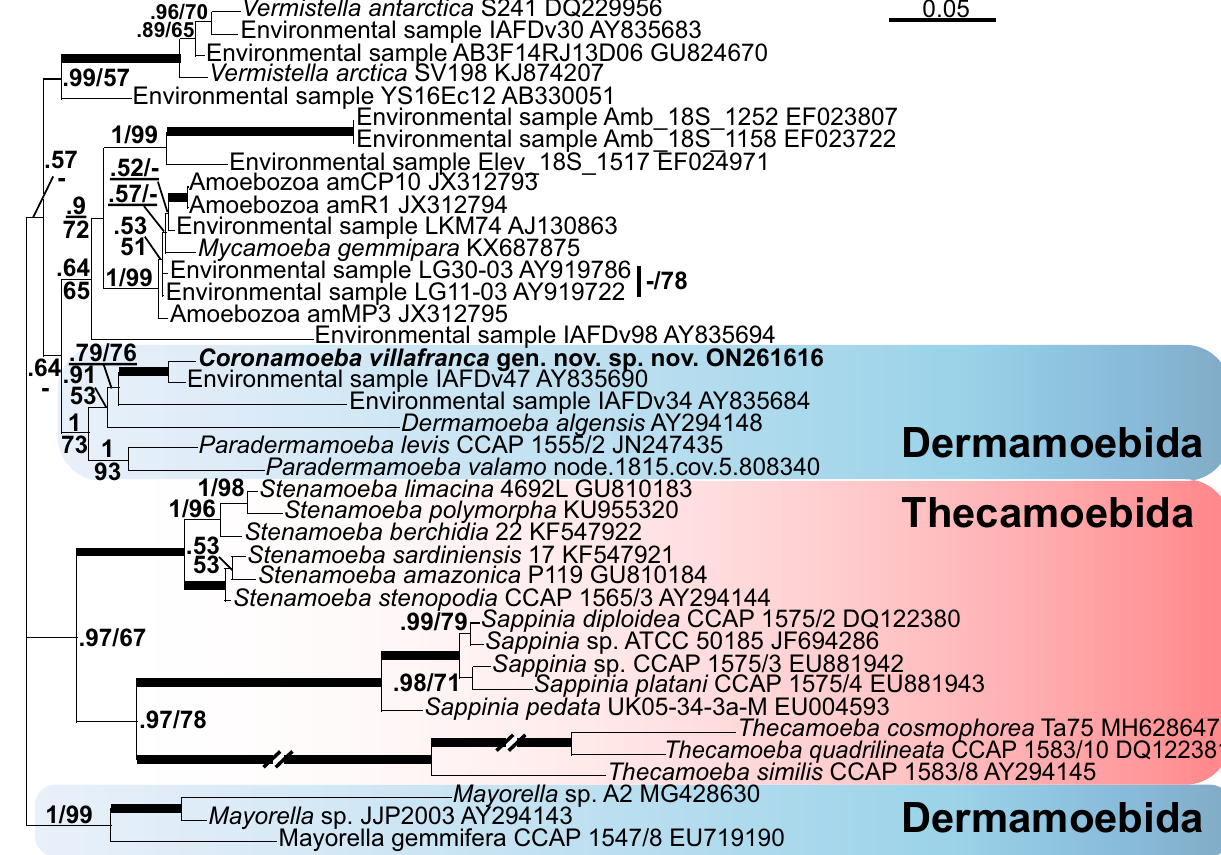
Figure 5. Part of the maximum likelihood phylogenetic tree based on the analysis of concatenated alignment of SSU rRNA and actin genes showing position of Coronamoeba villafranca gen. nov. sp. nov. (indicated in bold) among Dermamoebida and related clades. Numbers at nodes indicate posterior probabilities/bootstrap support values if above 0.5/50. Thick branches = 1/100. Scale bar 0.05